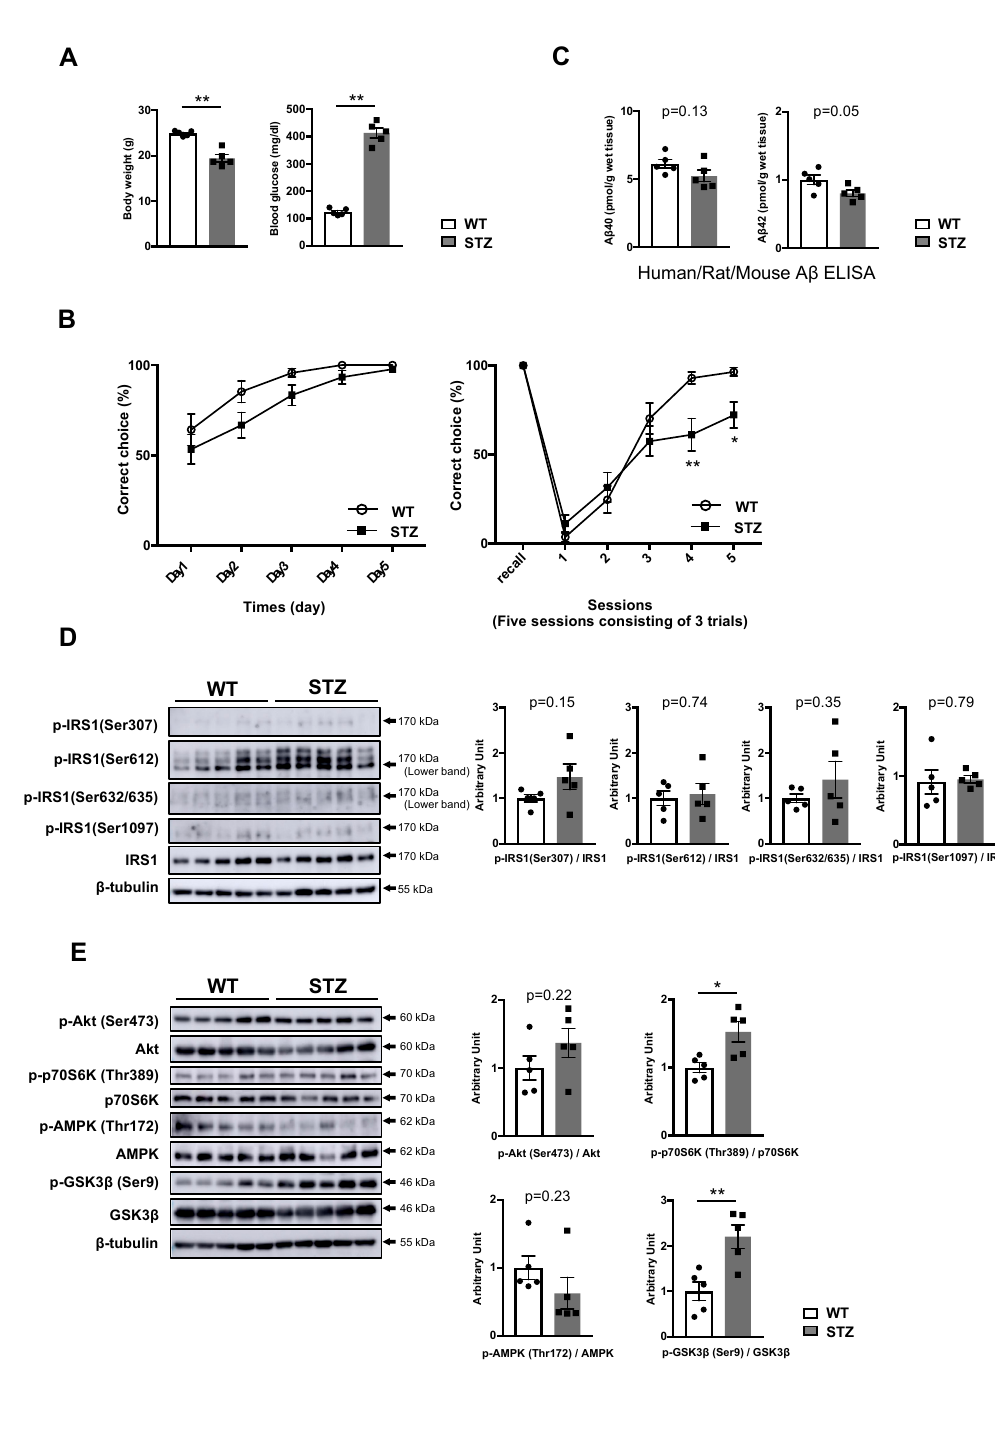
Figure 2. No alteration of IRS1 Ser phosphorylation in the hippocampus of T1DM mouse models. ( A ) Graphs of body weight and blood glucose level in wild-type (WT) and streptozotocin (STZ)-induced insulin-deficient type 1 diabetes (T1DM) model mice (10 weeks of age, n = 5 mice per group). ( B ) Evaluation of hippocampus-dependent learning and memory function and hippocampus/prefrontal cortex associated working memory function in WT (10 weeks of age, n = 19 mice per group) and